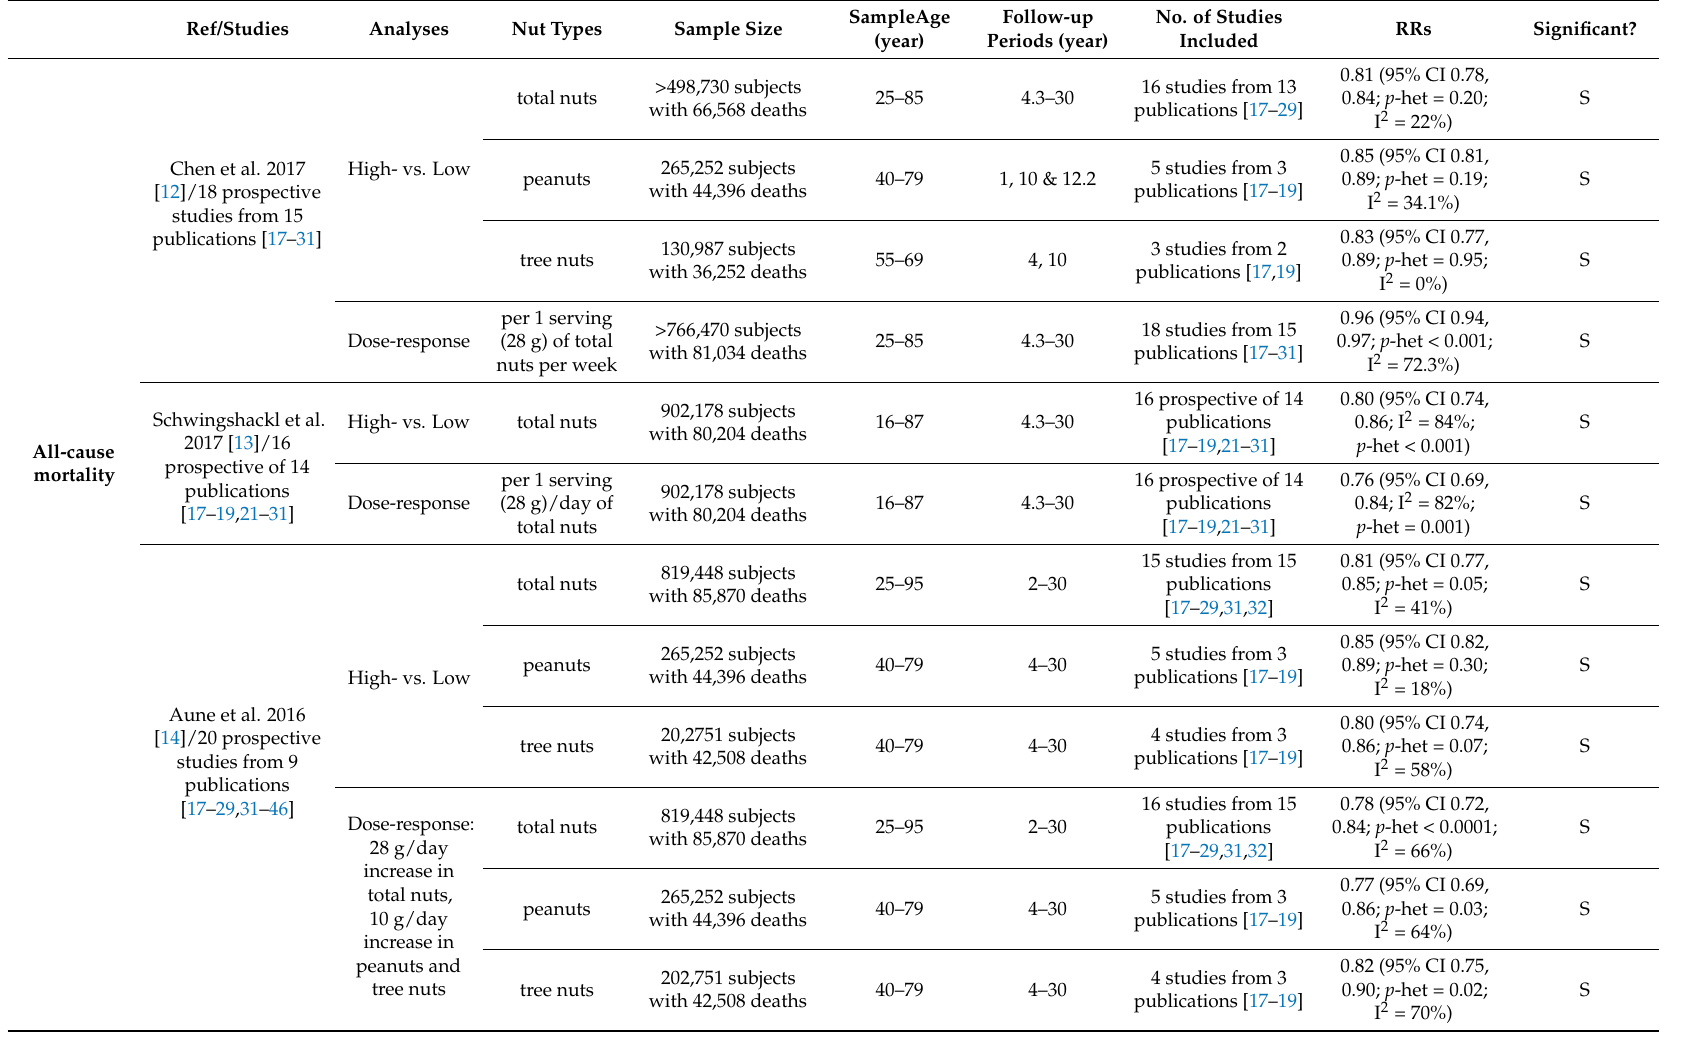
Table 1. Summary of nut consumption and all-cause, CVD, CHD, stroke, diabetes mortality in meta-analyses of prospective cohort